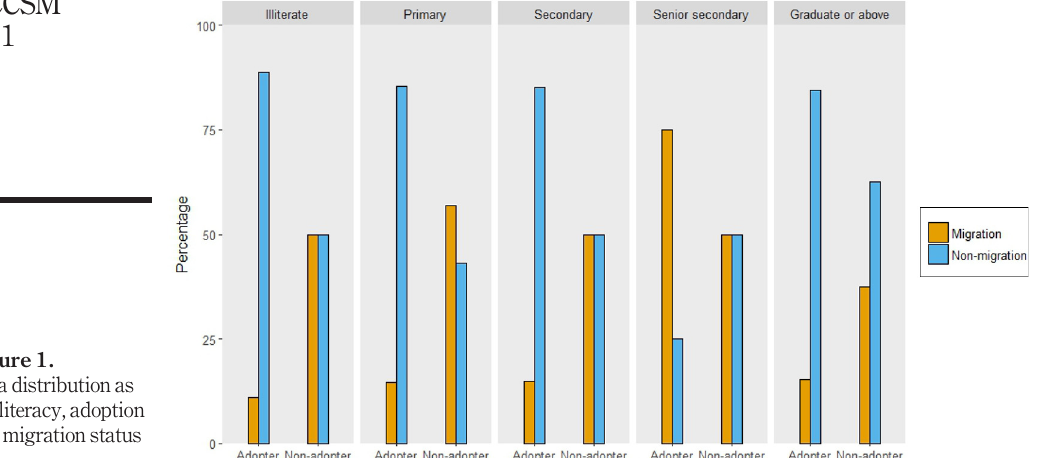
Figure 1. Data distribution